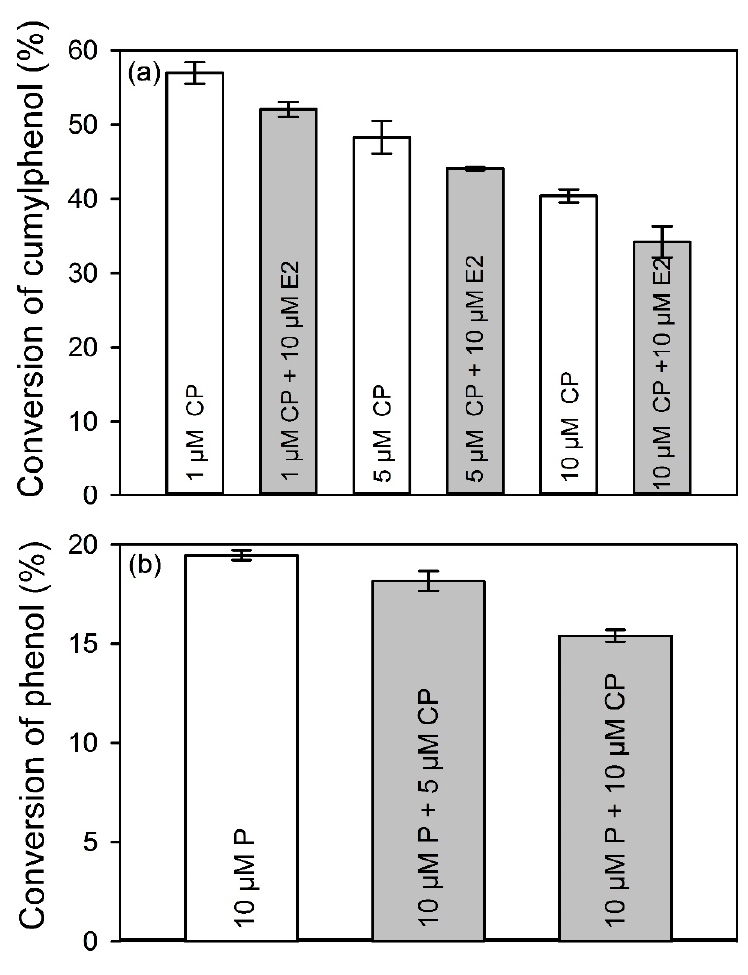
Figure 3. Effects of faster substrates on the conversion of slower substrates in multi-substrate experiments using 26 nM laccase after 3 h: ( a ) effect of 10 μ M estradiol (fast rate, moderate inactivation) on the conversion of cumylphenol (intermediate rate, high inactivation) with initial concentrations of 1, 5, and 10 μ M; ( b ) effects of 5 and 10 μ M cumylphenol (intermediate rate, high inactivation) on the conversion of 10 μ M phenol (slow rate, non-inactivating).